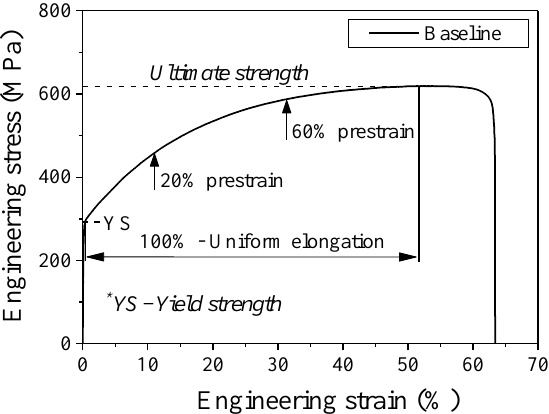
Figure 2. A stress – strain curve of a baseline specimen.